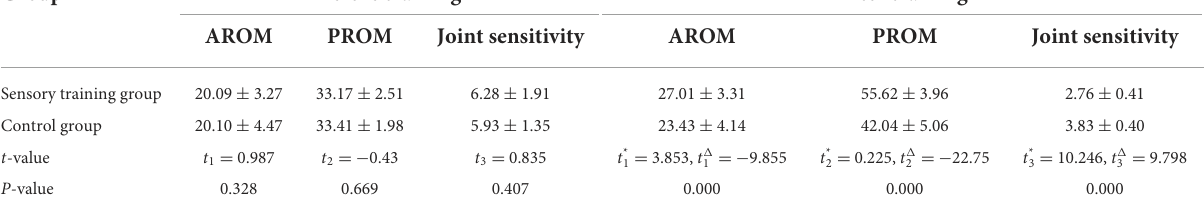
TABLE 2 Biomechanical index assessments in AROM, PROM, joint sensitivity. Group Before